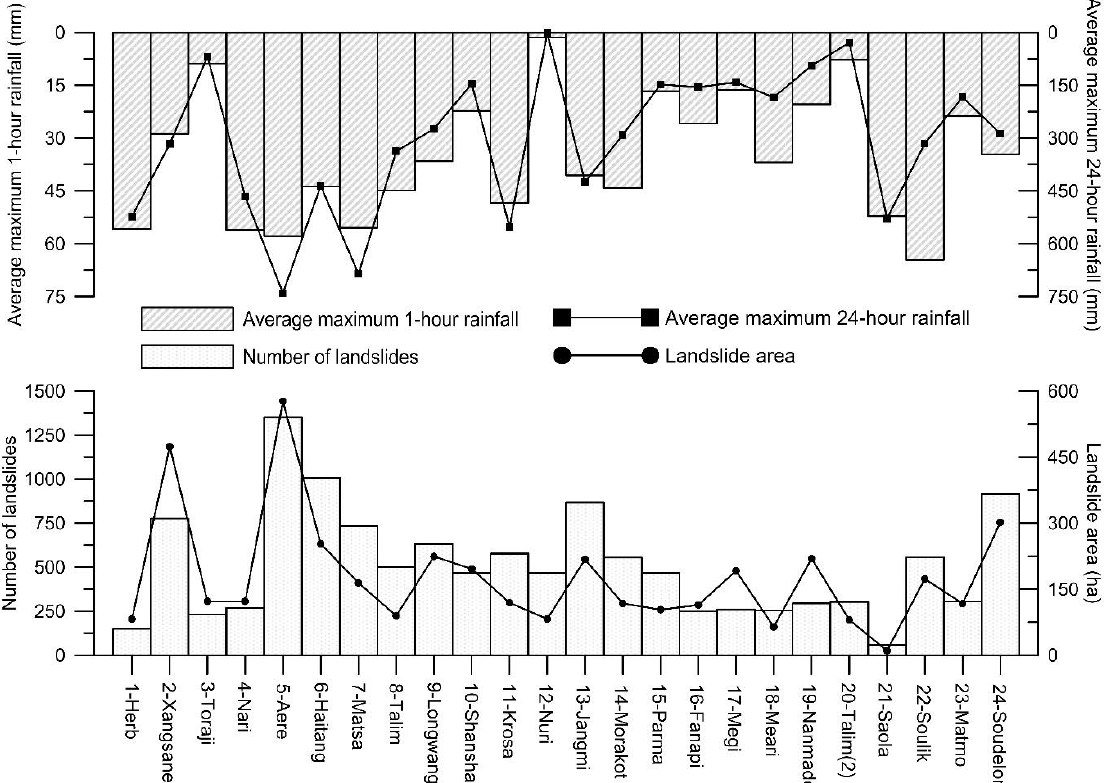
Figure 3. Landslide inventory and rainfall statistics for 24 typhoon events.